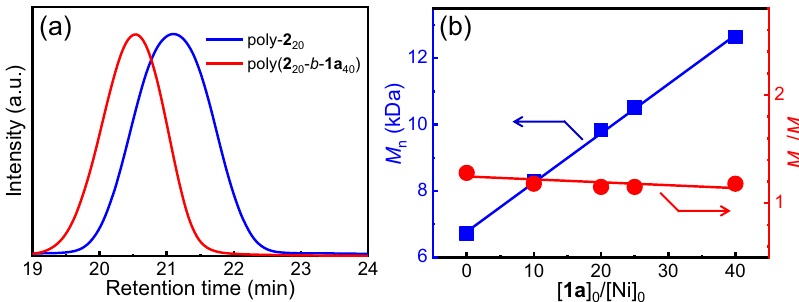
Fig. 6 SEC analyses of block copolymerization. a SEC traces of poly- 2 20 and the corresponding poly( 2 20 - b - 1a 40 ) copolymer. b Plots of the M n and M w / M n data of poly( 2 20 - b - 1a n )s vs . [ 1a ] 0 /[Ni] 0 ratio for the copolymerization of 1a initiated by poly- 2 20 with the Ni(II) complex at the chain